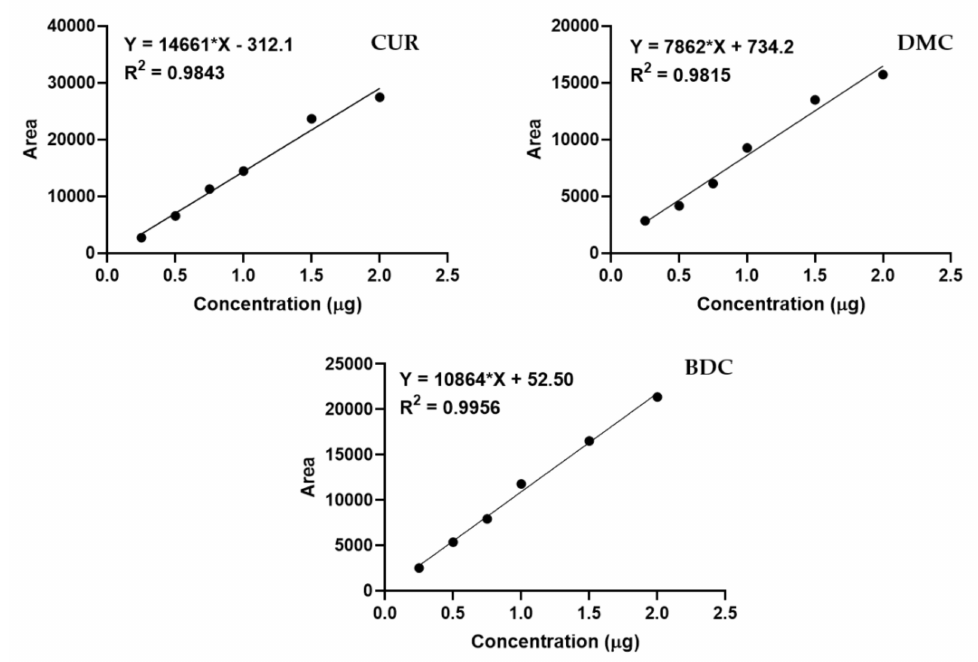
Figure 2. Linearity graphs of individual components of curcuminoids, namely curcumin (CUR), demethoxycurcumin (DMC), and bisdemethoxycurcumin (BDC), used for quantitative analysis of oil extracts of